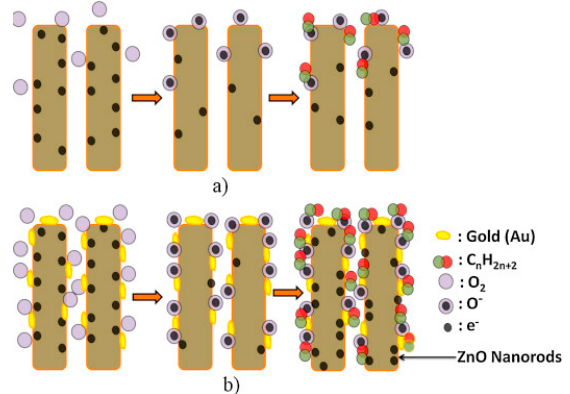
Figure 15. Schematic diagram of alkanes sensing of ( a ) pure ZnO nanorods and ( b ) Au functionalized nanorods [127].